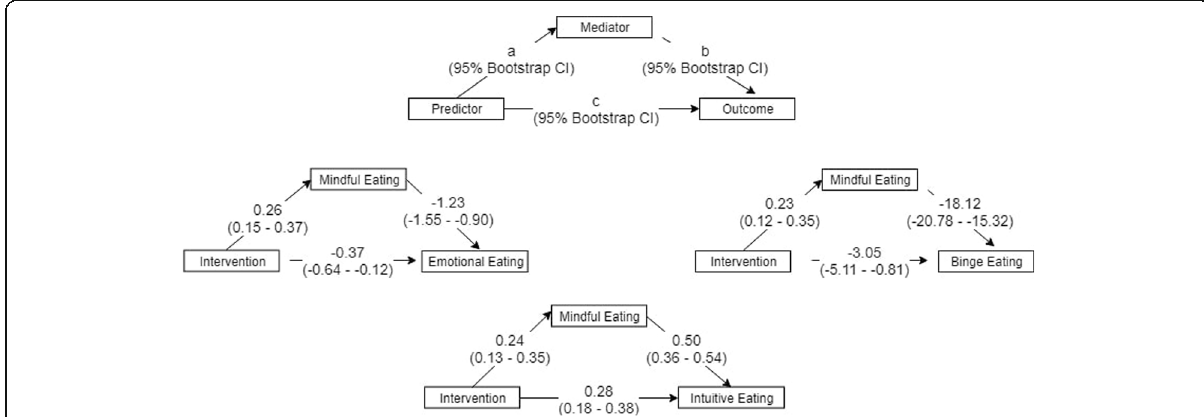
Fig. 4 Path models for direct effects and mediation estimates. Each model shows relationships among three variables: a predictor, a mediator, and an outcome. The intervention is the predictor on all three models, and mindful eating is the mediator. The outcomes are emotional eating, intuitive eating, and binge eating. Numbers on the arrows indicate the path coefficients for the effect of the predictor on the mediator ( a path), effect of the mediator on the outcome ( b path), and the effect of the predictor on the outcome ( c path). The 95% confidence intervals for the path coefficients were calculated with the bootstrap method and are shown in parenthesis below each